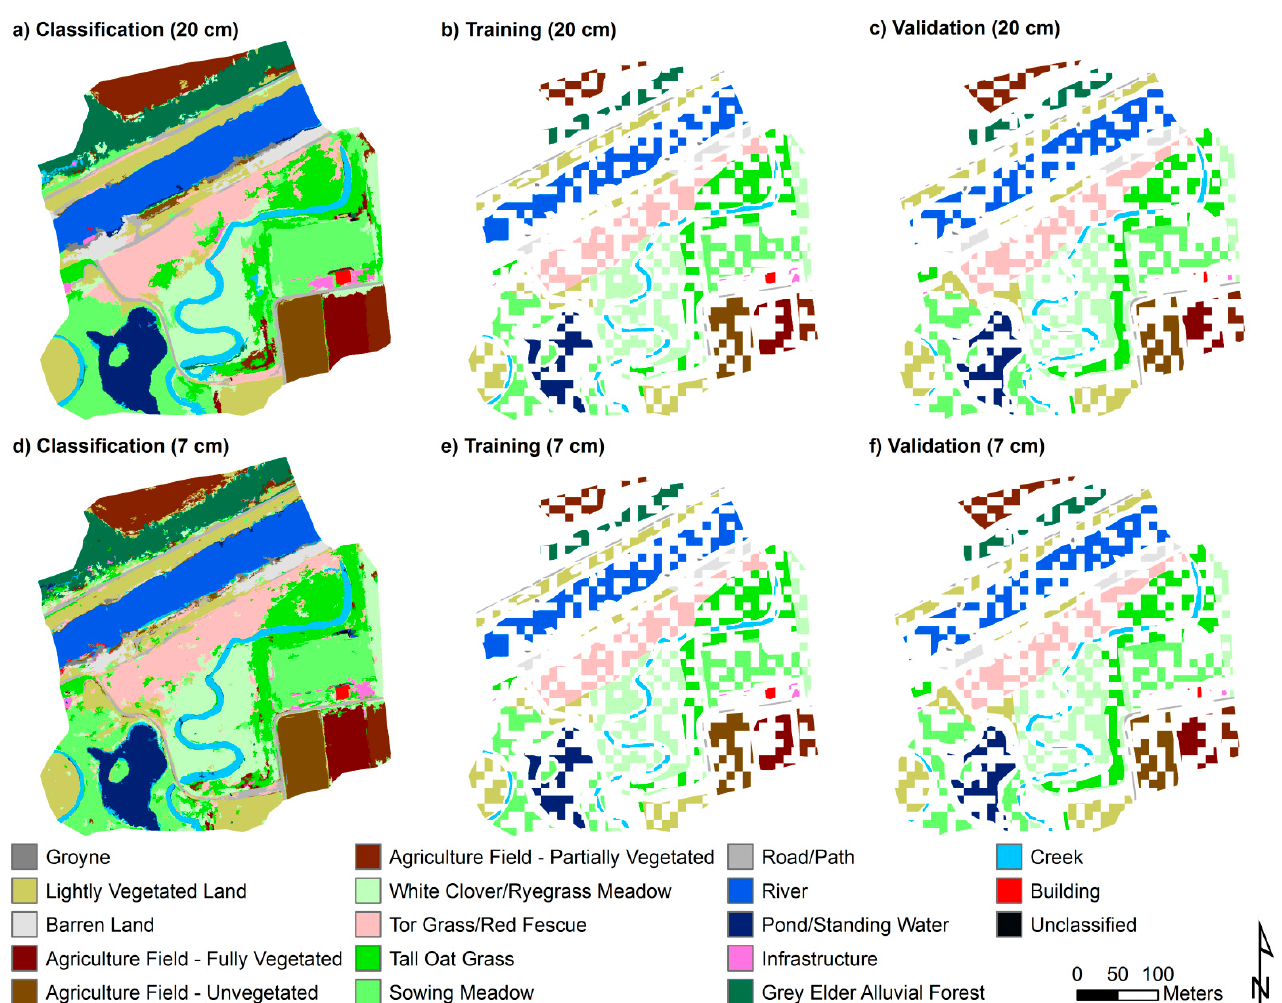
Figure 7. ( a ) Land cover classification of the 20 cm pixel size narrow-band 11 April 2016 image of the River Gail generated using eCognition ® ; ( b ) Training data used in eCognition ® for generating the land cover image in ( a ); ( c ) Validation data used in the accuracy assessment of the land cover image in ( a ); ( d ) Land cover classification of the 7 cm pixel size narrow-band 11 April 2016 image of the River Gail generated using eCognition ® ; ( e ) Training data used in eCognition ® for generating the land cover image in ( d ); ( f ) Validation data used in the accuracy assessment of the land cover image in ( d ).